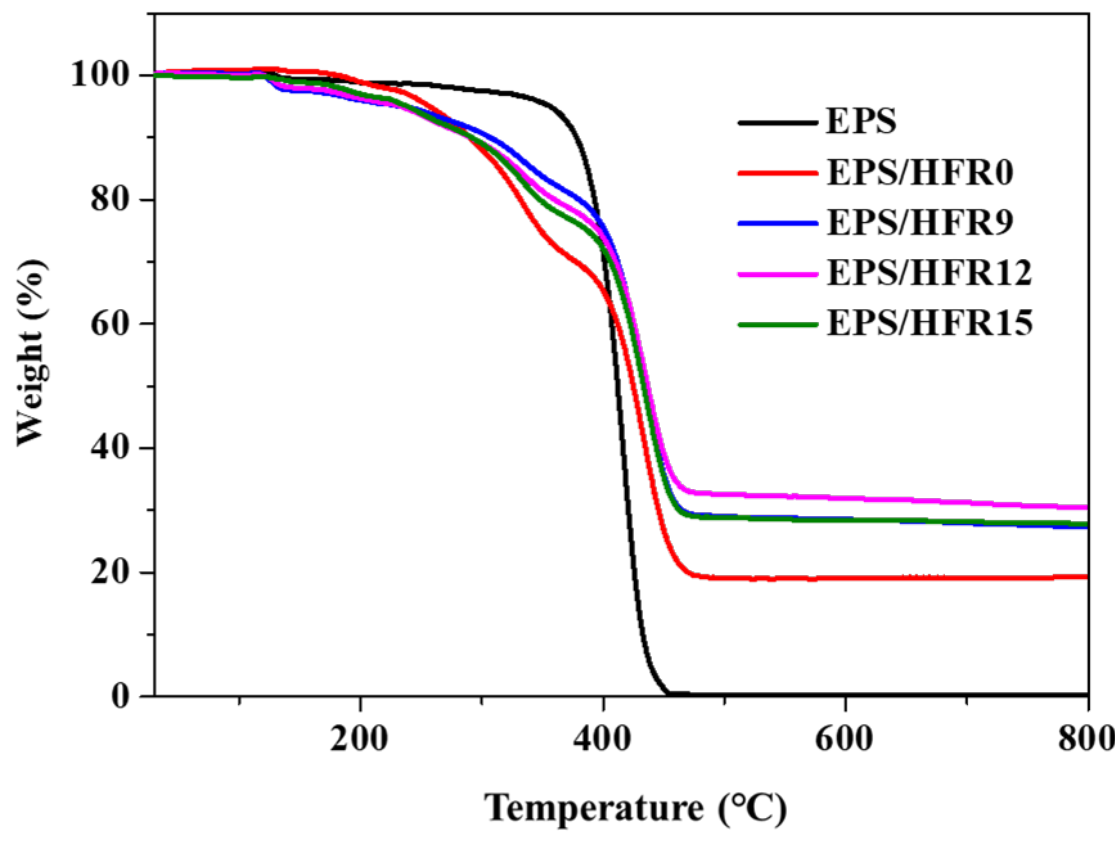
Figure 1. The TGA curves of the neat EPS and flame-retardant EPS samples obtained under a nitrogen atmosphere at a heating rate of 10 °C/min.